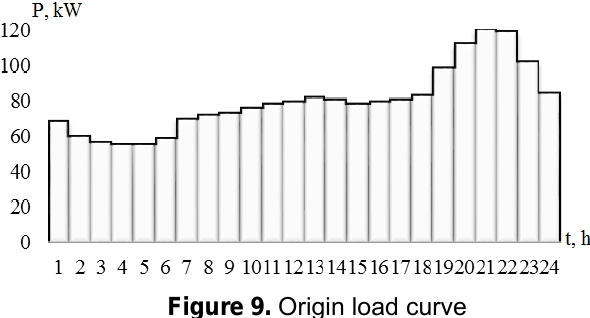
Figure 9. Origin load curve